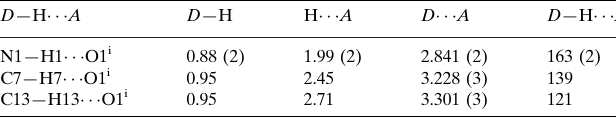
Bruker APEXII CCD diffractometer